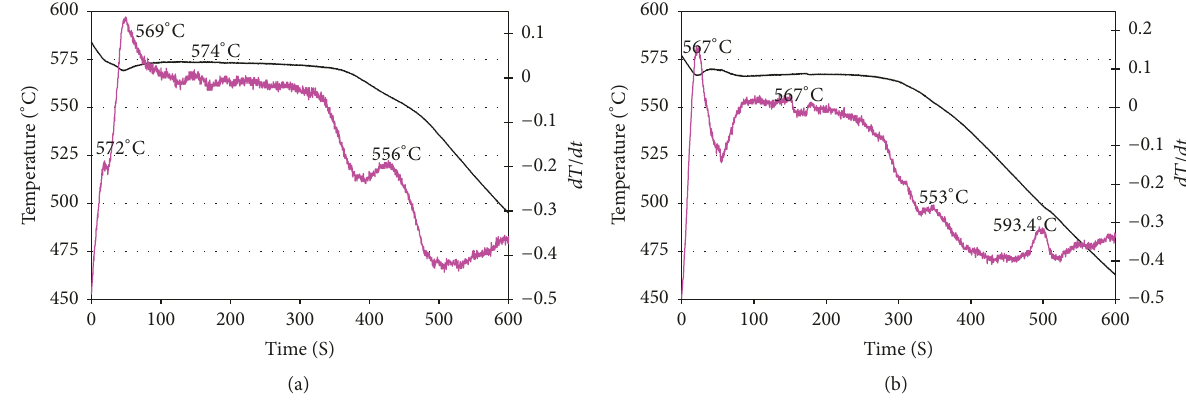
Figure 3: Solidification curves and their 1st derivatives obtained from (a) base alloy and (b) base alloy + 80ppm Sr.